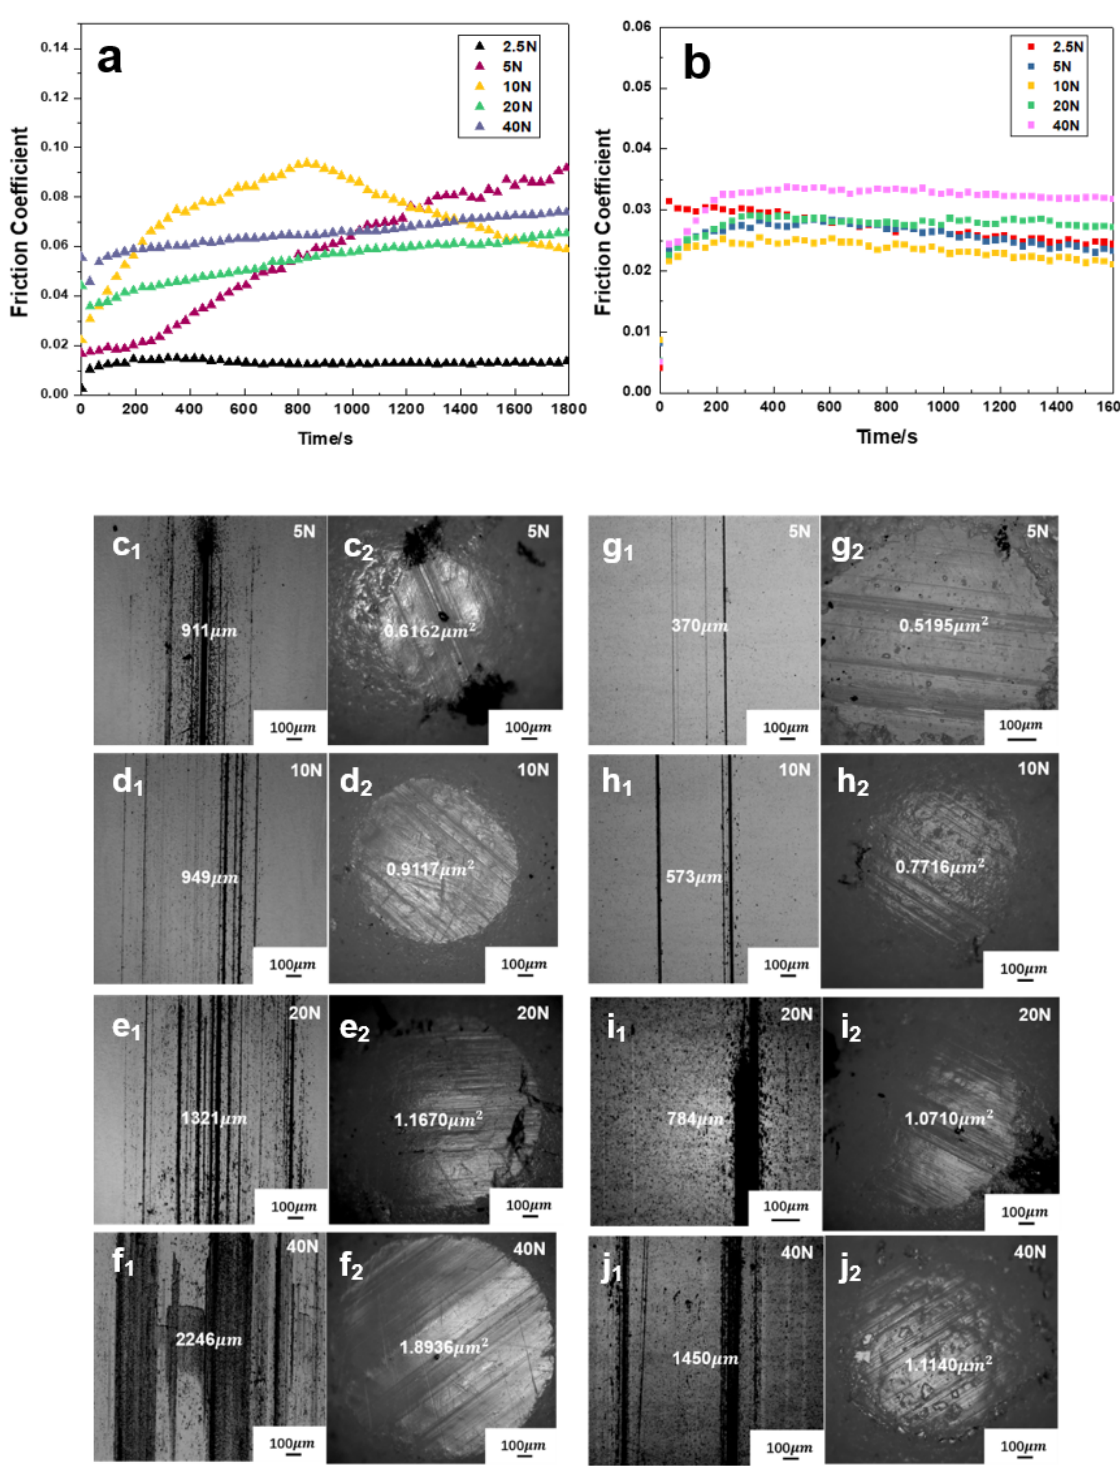
Figure 6. Tribological properties of bare Ti6Al4V and inorganic thermal oxide-coated Ti6Al4V at different loads: ( a ) friction coefficient of bare Ti6Al4V versus time; ( b ) friction coefficient of inorganic thermal oxide-coated Ti6Al4V versus time; ( c 1 – f 1 ) wear morphologies of bare Ti6Al4V with applied loads of ( c 1 ) 5 N, ( d 1 ) 10 N, ( e 1 ) 20 N, and ( f 1 ) 40 N; ( c 2 – f 2 ) wear morphologies of PTFE balls (tribo-pairs of bare Ti6Al4V) with applied loads of ( c 2 ) 5 N, ( d 2 ) 10 N, ( e 2 ) 20 N, and ( f 2 ) 40 N; ( g 1 – j 1 ) wear morphologies of inorganic thermal oxide-coated Ti6Al4V with applied loads of ( g 1 ) 5 N, ( h 1 ) 10 N, ( i 1 ) 20 N, and ( j 1 ) 40 N;( g 2 – j 2 ) wear morphologies of PTFE balls ( tribo-pairs of inorganic thermal oxide-coated Ti6Al4V) with applied loads of ( g 2 ) 5 N, ( h 2 ) 10 N, ( i 2 ) 20 N, and ( j 2 ) 40 N.